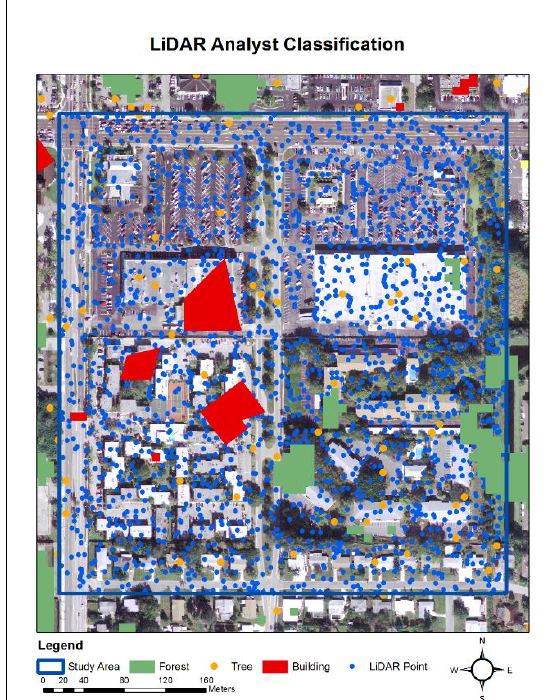
Figure 3. LiDAR Analyst Classification Result from the Sparse LiDAR Points